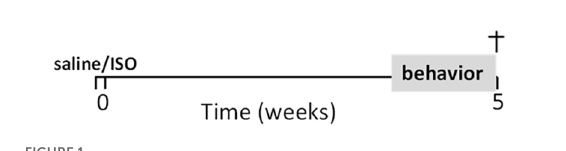
FIGURE1 Experimental protocol. ISO,